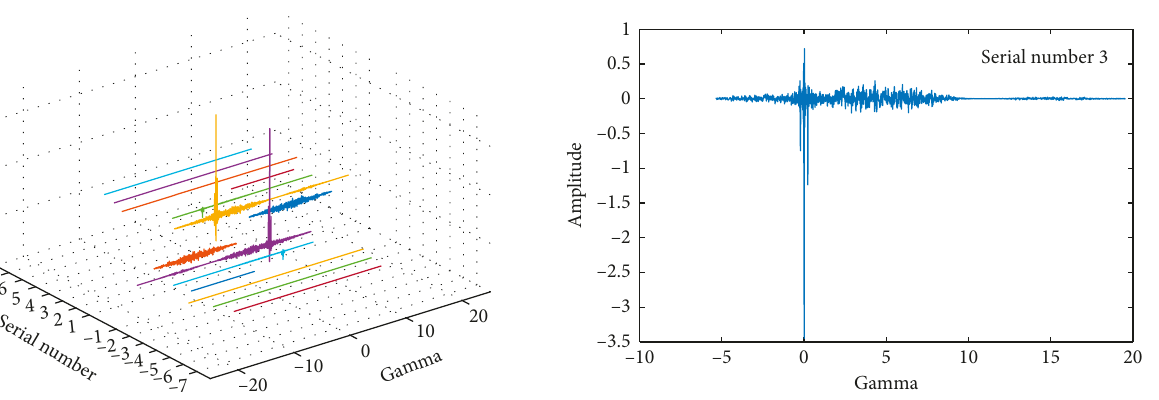
Figure 9: The real part of the signals in the frequency domain. Figure 10: The real part of the positive signal in the frequency domain.